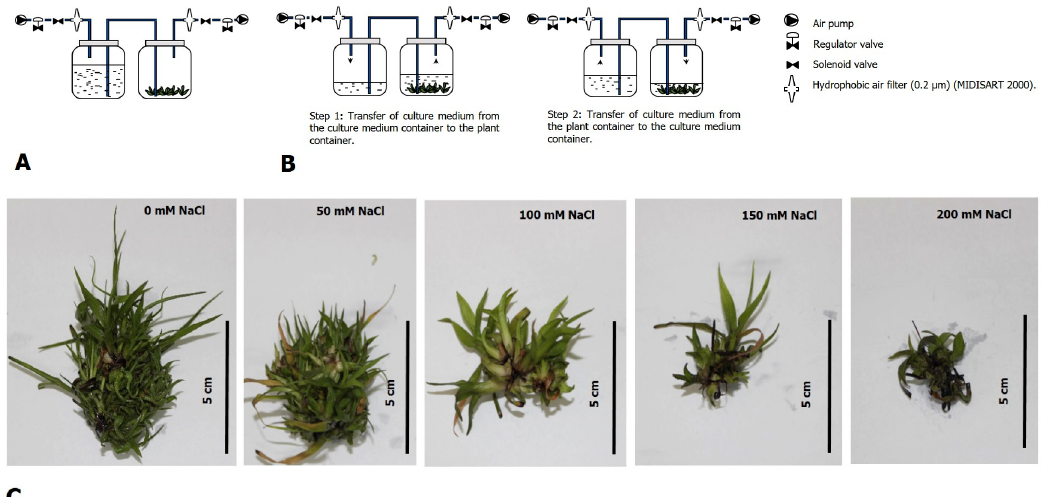
Fig. 1: Design of the temporary immersion bioreactor used and typical shoots produced. A Temporary immersion bioreactor. B More of operation of a temporary immersion bioreactor. Immersions (2 min each) were performed every 3 h during 30 d. C Typical phenotypes of sugarcane shoots pro- duced in temporary immersion bioreactors with different levels of NaCl. Glass containers with 300 ml of total capacity, 200 ml of liquid culture medium, and silicone tubes were used. Five explants per container were cultured (40 ml medium / explant). Shoots were free in the bottom of con- tainers. The design of temporary immersion bioreactor was previously described by L orenzo et al. (1998) and e scaLona et al.